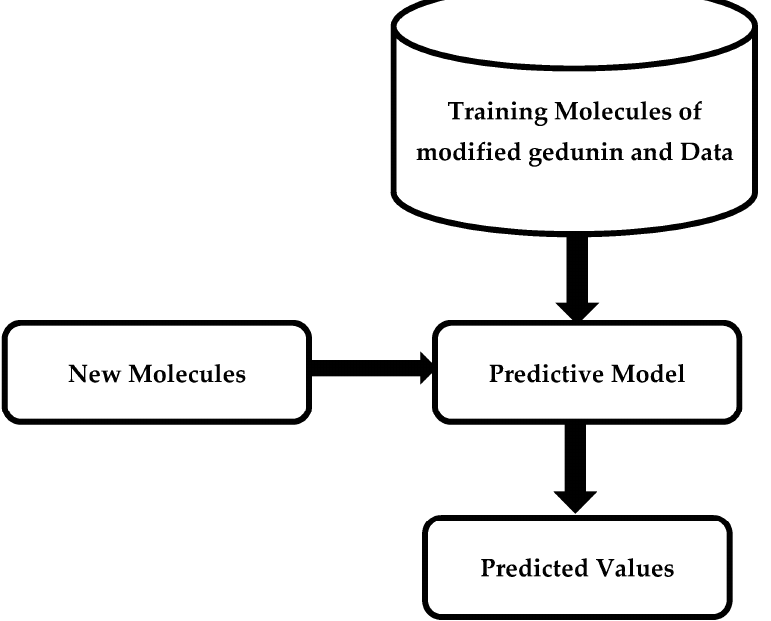
Figure 6. A diagram illustrating the predictive modelling